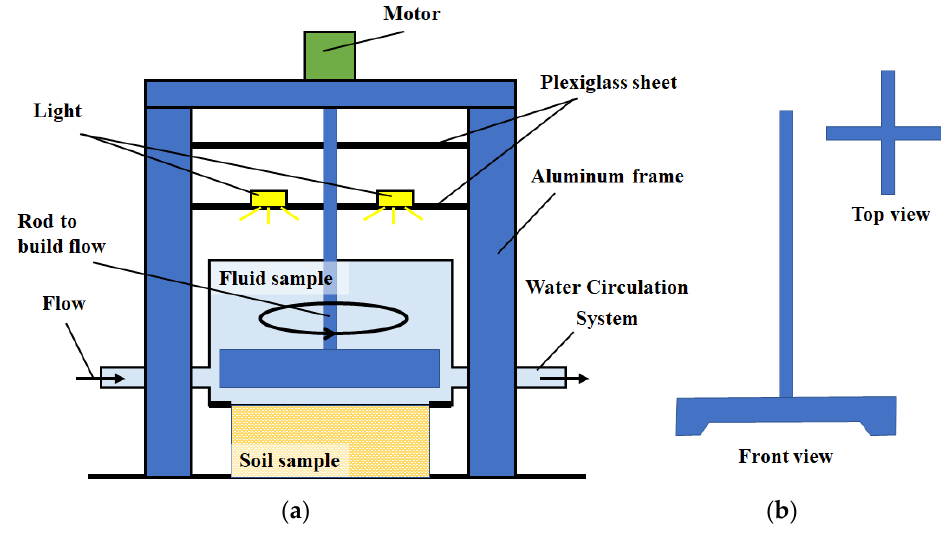
Figure 7. The schematic diagram of the SSRT device. ( a ) SSRT device ( b ) Stirring rod.